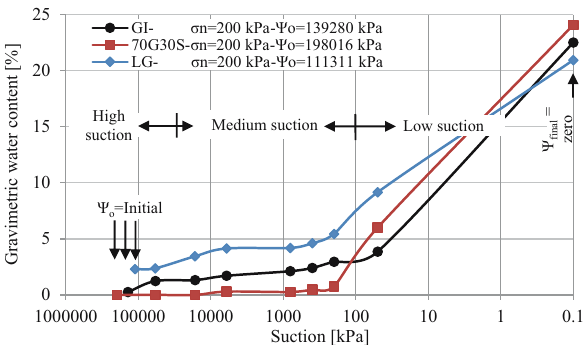
Figure 6: Variation of the gravimetric water content with suction of the ( CN - SD ) wetting